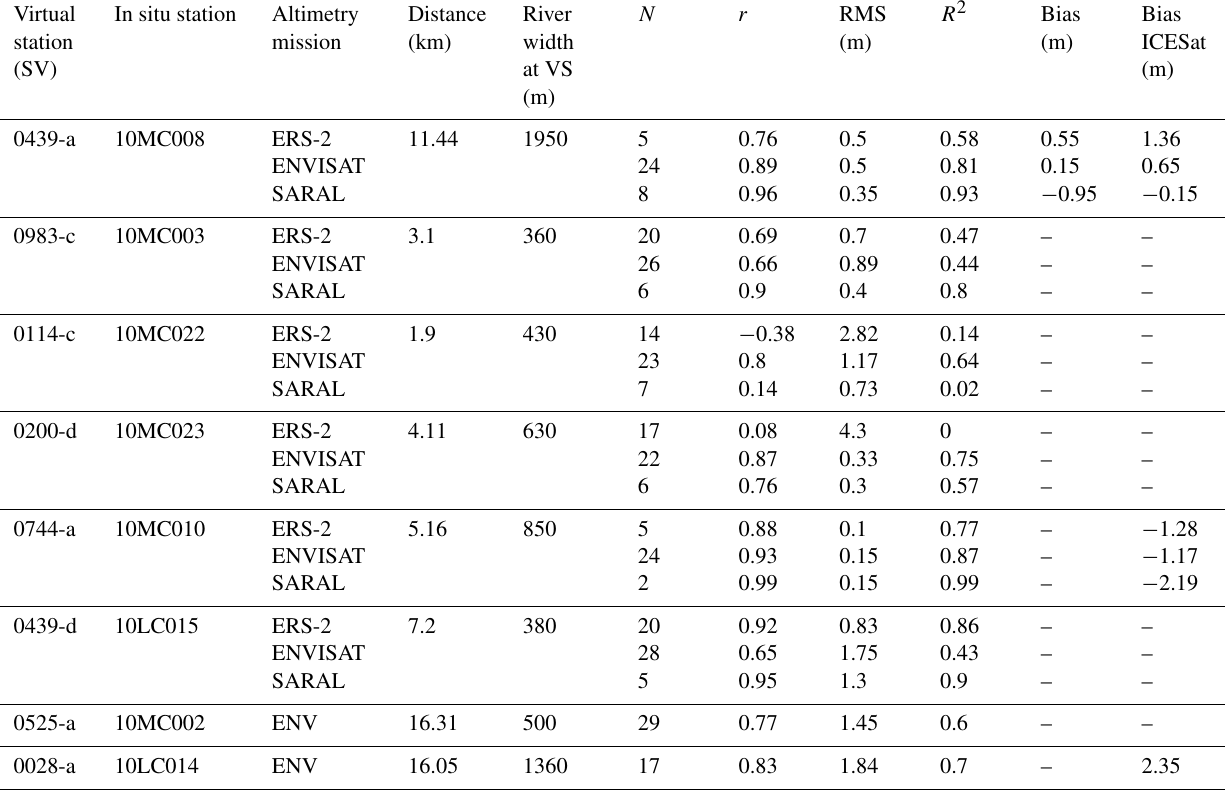
Table 3. Statistic parameters obtained between altimetry-based water levels from altimetry multi-mission and in situ water levels. Virtual station